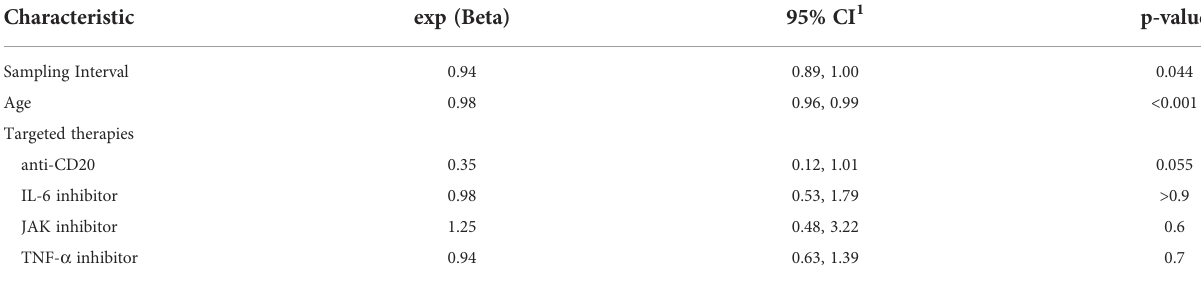
TABLE 4 Parameters of the optimized regression model for whole COVID virus-speci fi c CD4+ and CD8+ T-cell response. Characteristic Sampling